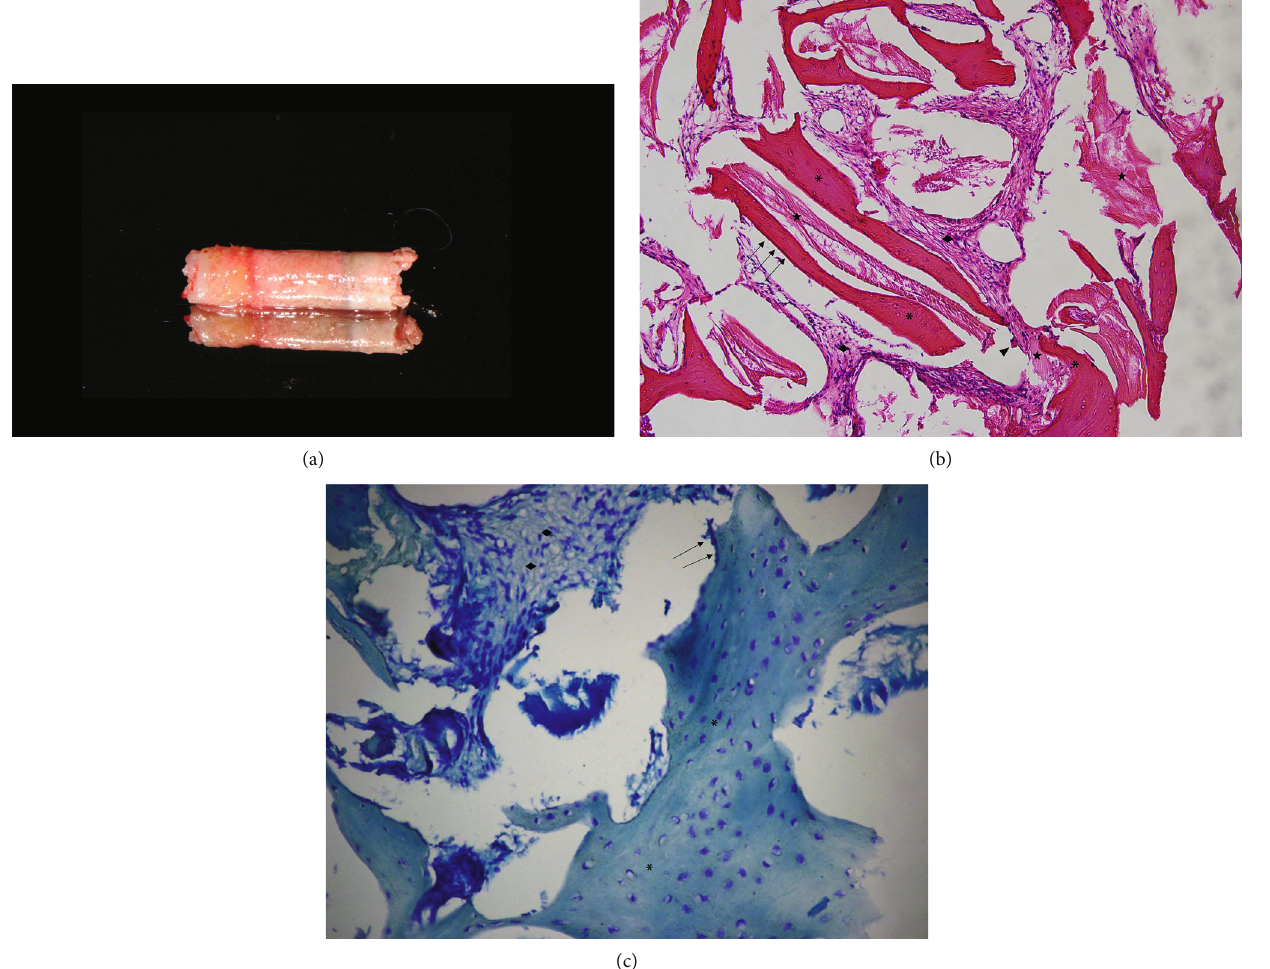
Figure 12: Histological evaluation of tooth #26. (a) The biopsy sample. (b) Representative section stained with hematoxylin-eosin (H&E) ( × 10). (c) Representative section stained with modi fi ed Mallory aniline blue ( × 20). Newly formed bone (asterisk), nonvital bone (star), blood marrow (diamond), bone lining cells (arrowhead), and an osteoclast (arrow) are